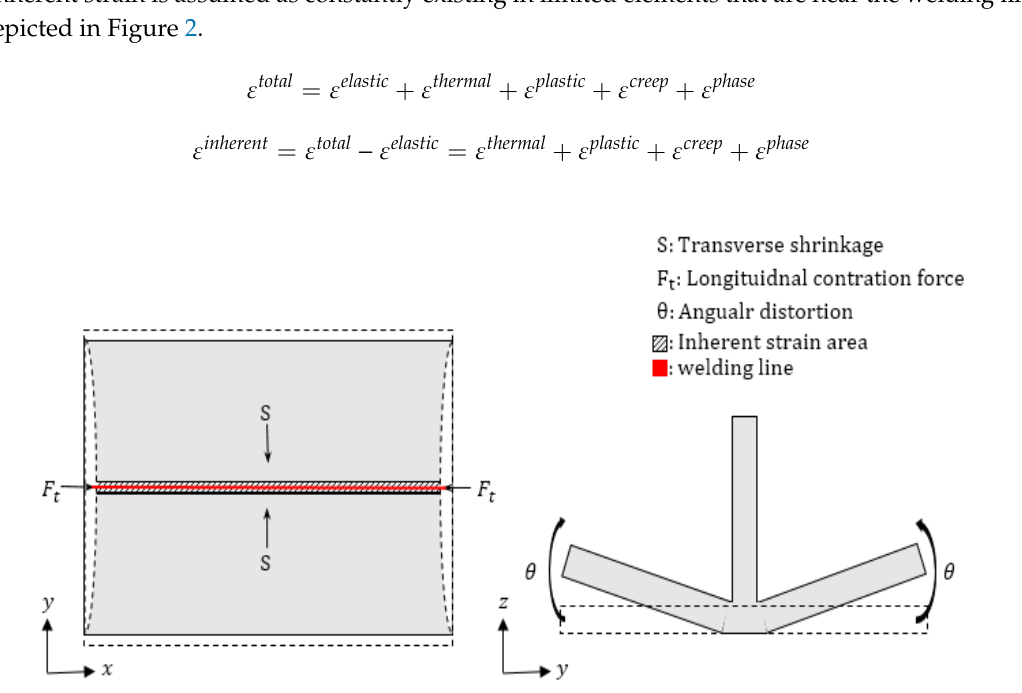
Figure 2. Application of inherent strain along welding line.